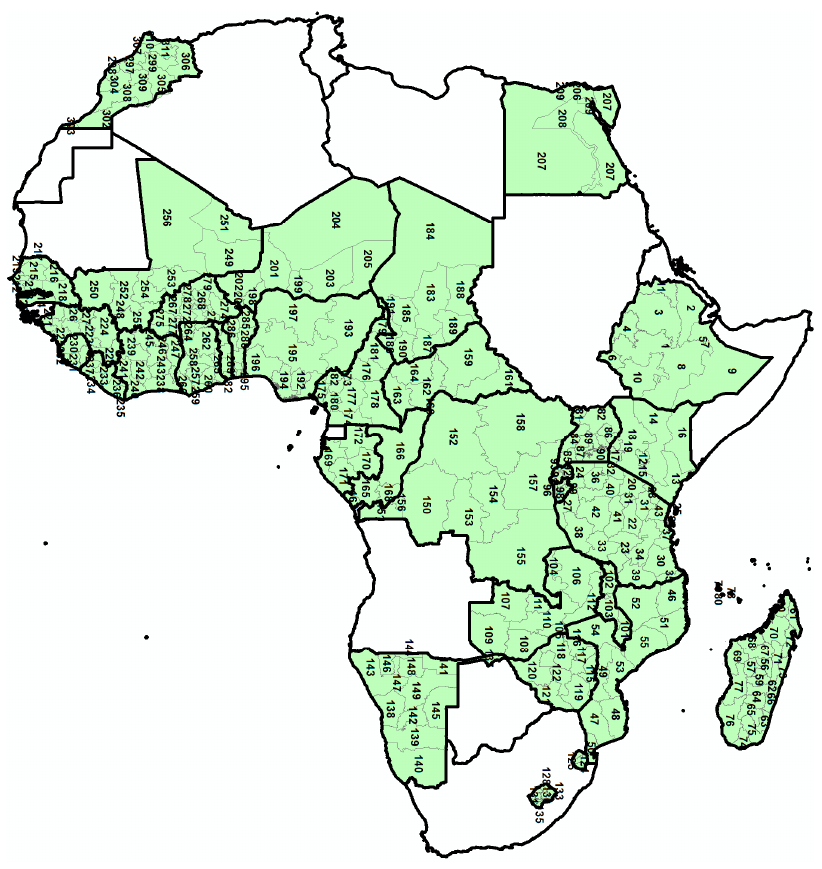
Figure 2. Study area at the DHS administrative level.